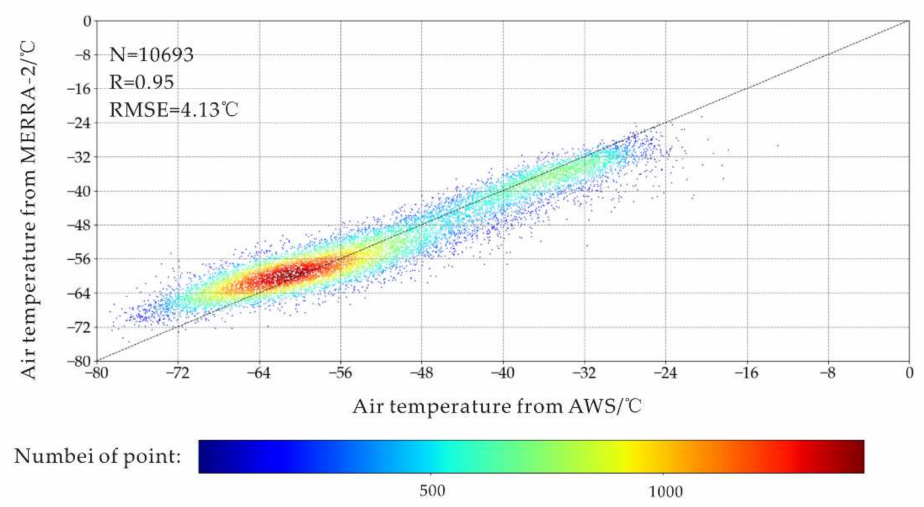
Figure 2. The comparison between air temperature from MERRA-2 and AWS (3 is specified as the radius and then each sample point is traversed, and the number of scattered points within the radius of each sample point is calculated to indicate the density of the scattered